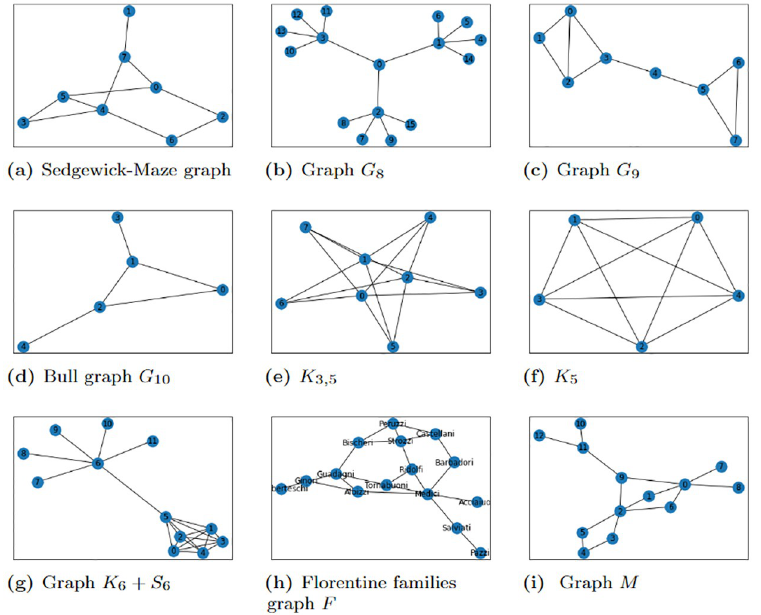
Fig 1. Small graphs considered. (a) Sedgewick-Maze graph, (b) Graph G 8 , (c) Graph G 9 , (d) Bull graph G 10 , (e) K 3,5 , (f) K 5 , (g) K 6 + S 6 , (h) Florentine families graph F , (i) Graph M .